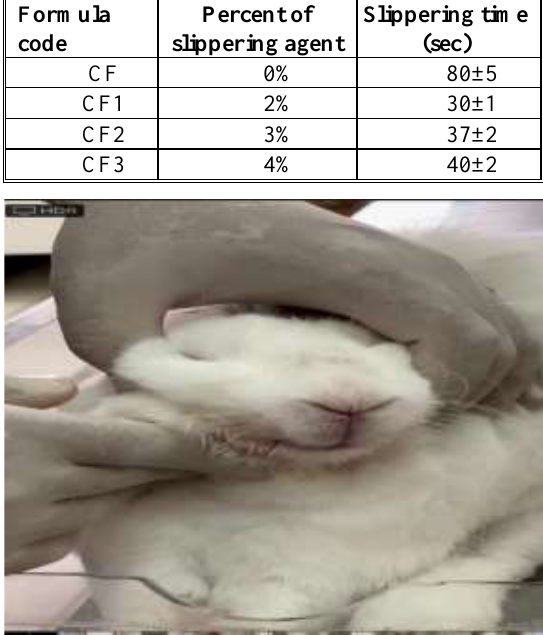
Table 8. Results of slipperiness test on Rabbit